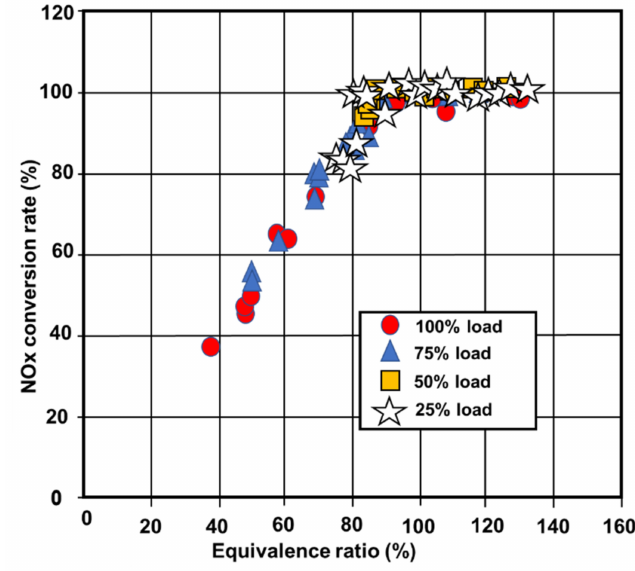
Figure 40. NOx conversion rate values against urea water solution equivalence ratio